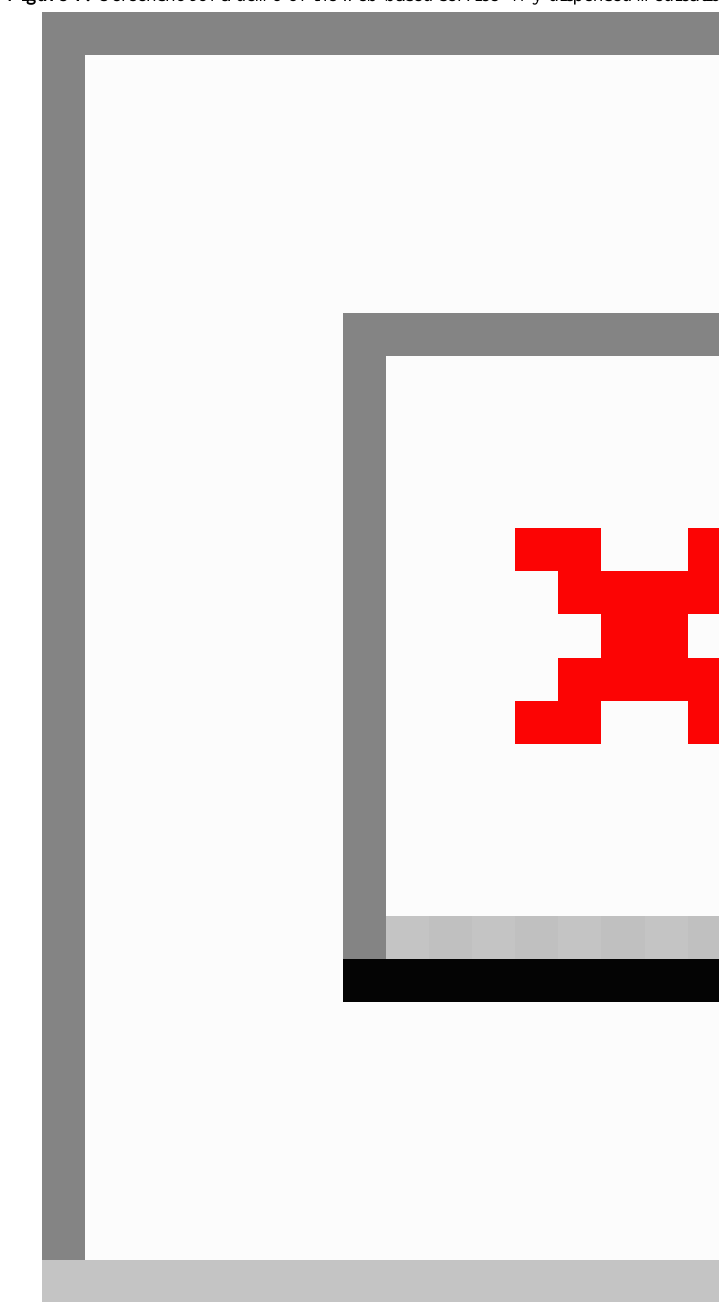
Figure 1. Screenshot of a demo of the web-based service “My dispensed medications” (English explanations in red